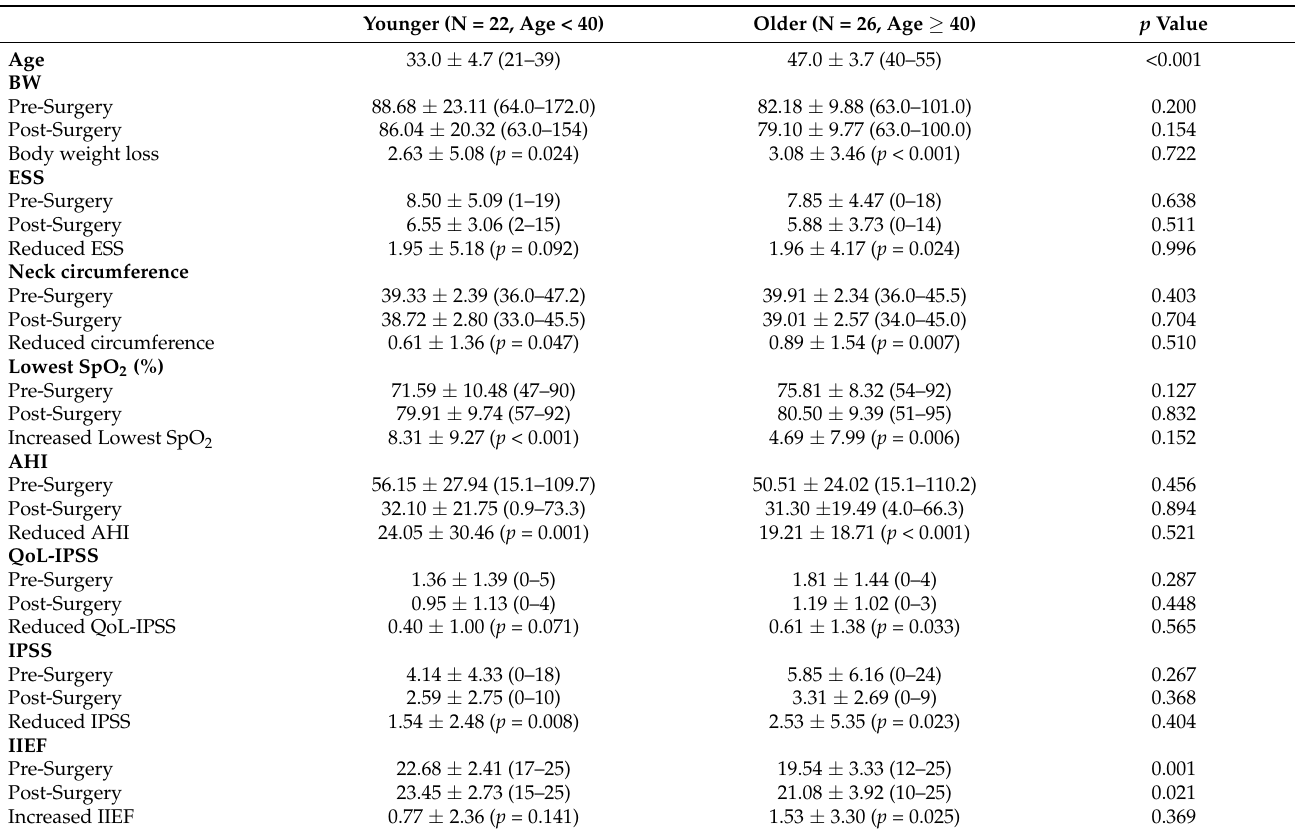
Table 3. Postoperative changes in the younger and older age subgroups.